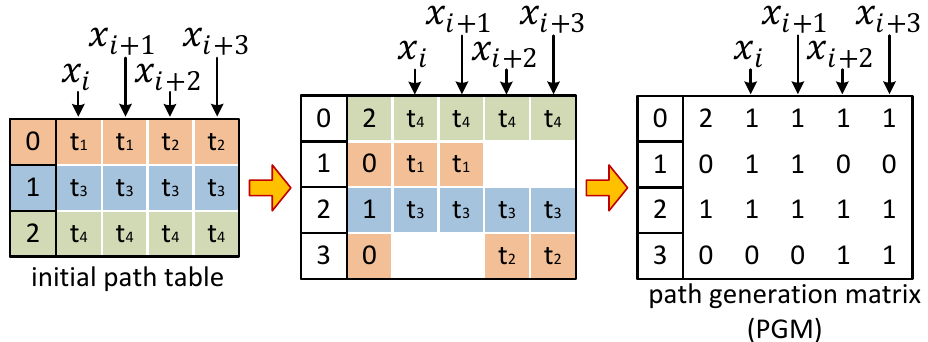
Figure 8. The generation mechanism of the path generation matrix.